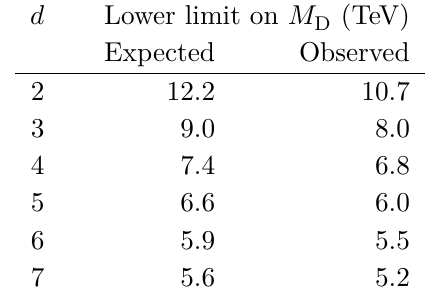
in TeV as functions of the D